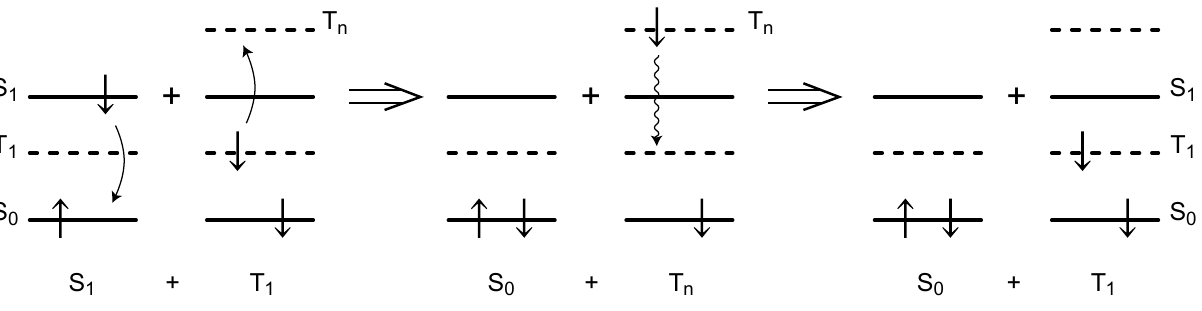
and T states Figure 28. Mechanism of singlet-triplet annihilation. When a pair of the S 1 1 becomes close-by, a resonance electron transfer takes place, one downward and the other singlet-excited state becomes annihilated and the T state upward. As a result, the S 1 1 triplet state (the left → middle transformation; an overall becomes excited to an upper T n + T state is generated). Then, the T state quickly relaxes down to the T state, because S 1 n n 1 + T the inversion of spin is unnecessary (the middle → right transformation; an overall S 0 1 → S singlet transformation is state resulted). Through this two-steps of reaction, the S 1 0 state, which is called ‘singlet-triplet mediated by the T 1